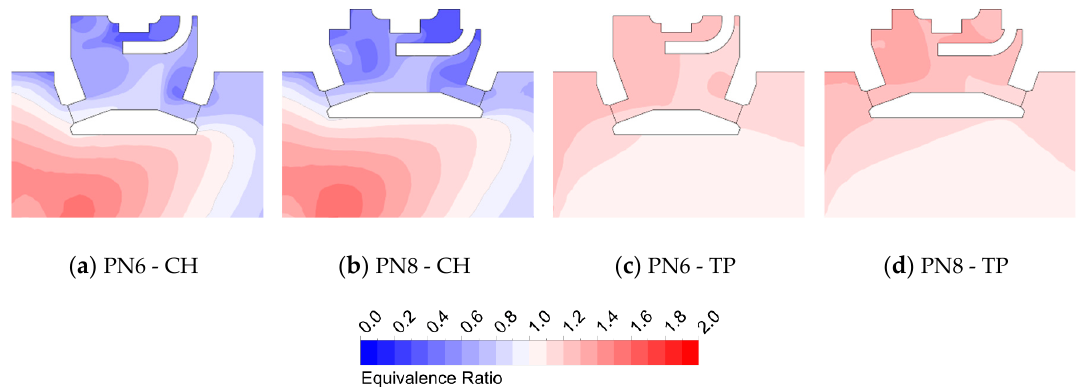
Figure 20. Equivalence ratio contours inside the prechamber at top dead center (TDC) for the 7500 rpm and full load case: comparison between the two prechamber geometries for both injection strategies.